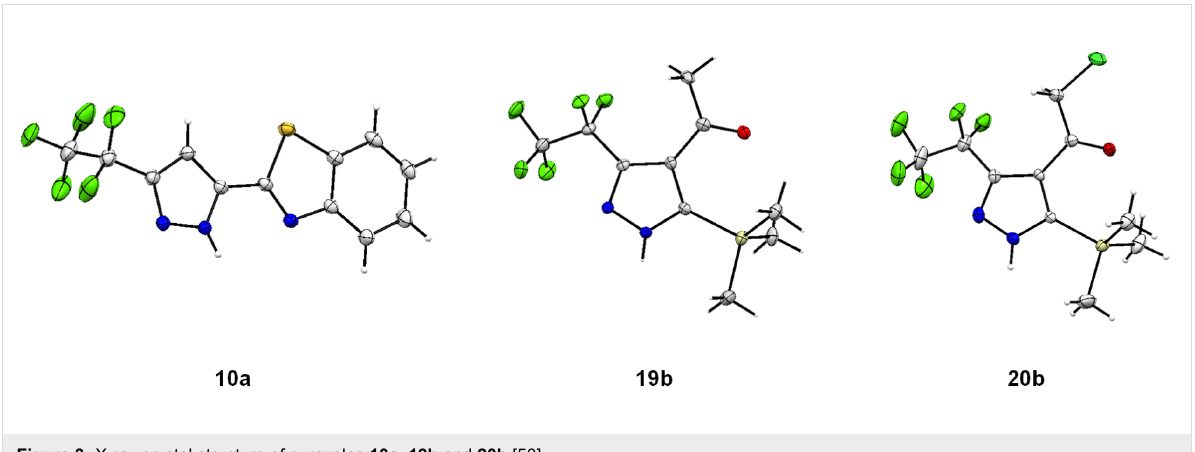
Figure 3: X-ray crystal structure of pyrazoles 10a , 19b and 20b [50].